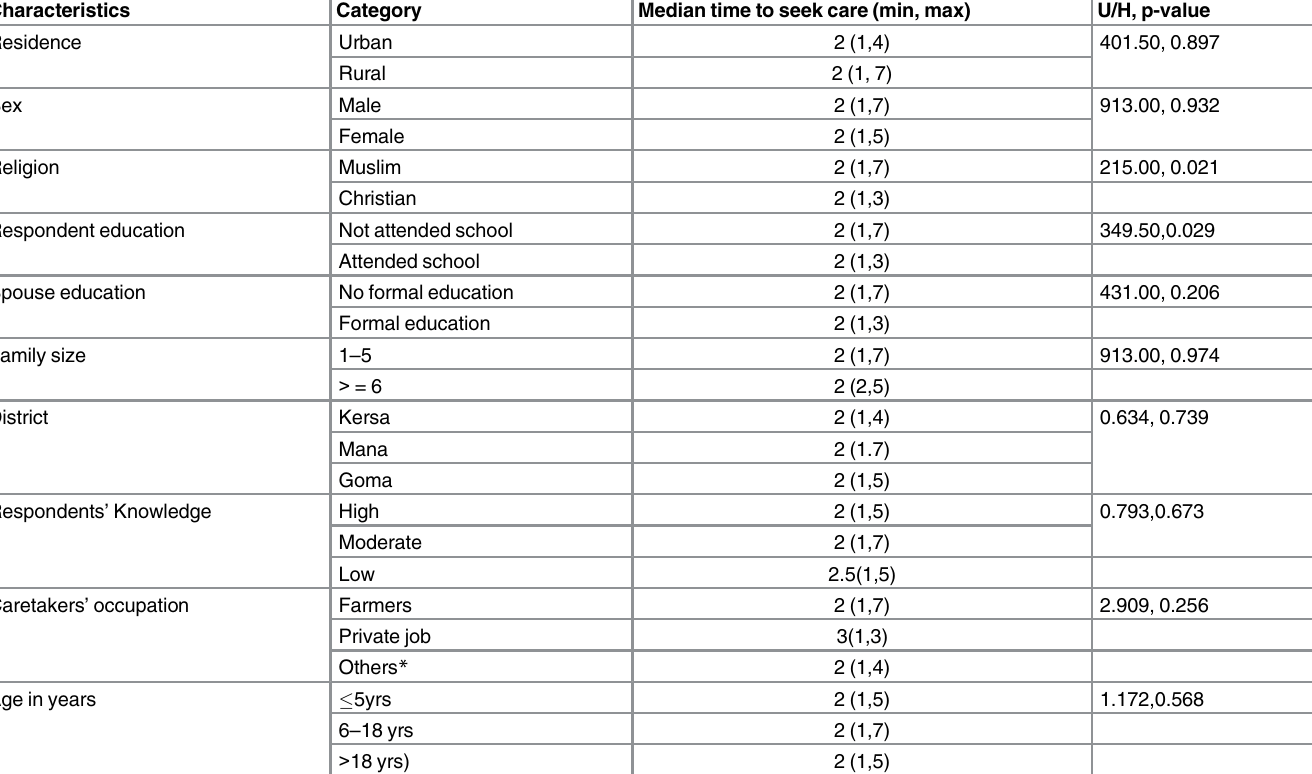
Table 3. Mann-Whitney (U) and Kruskal Wallis (H) tests for median time difference for seeking first care after onset of fever, Jimma, Ethiopia.